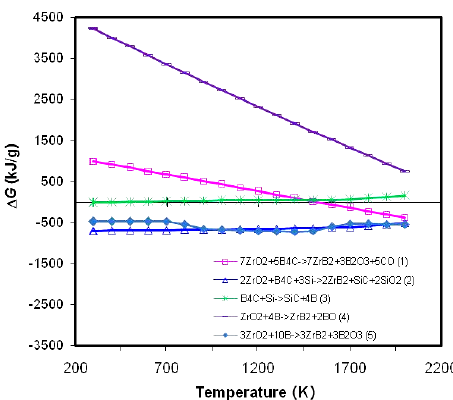
Fig. 2 Gibbs free energy of different reactions as a function of